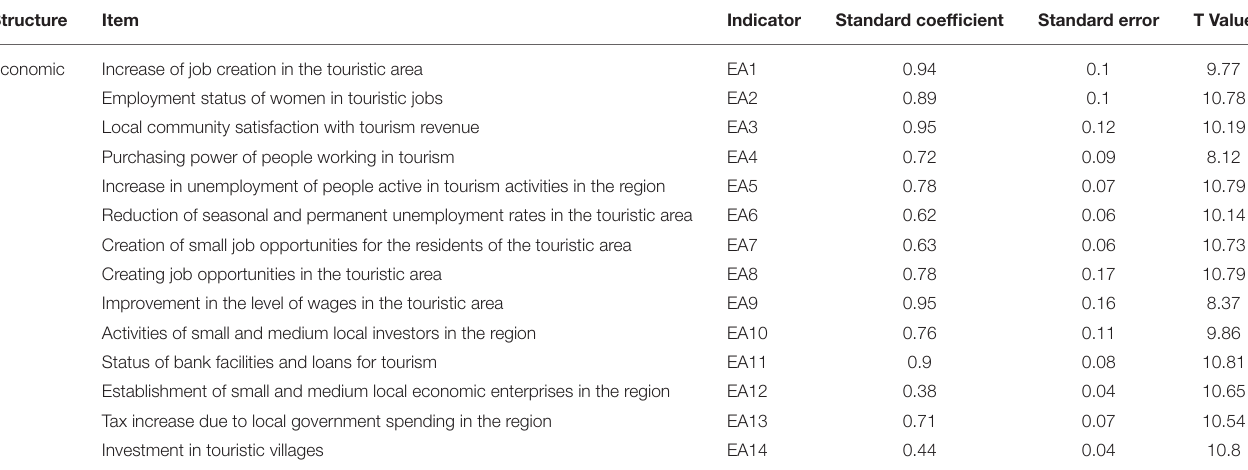
TABLE 1 | Summary of results obtained from the economic effects model (confirmatory factor analysis).